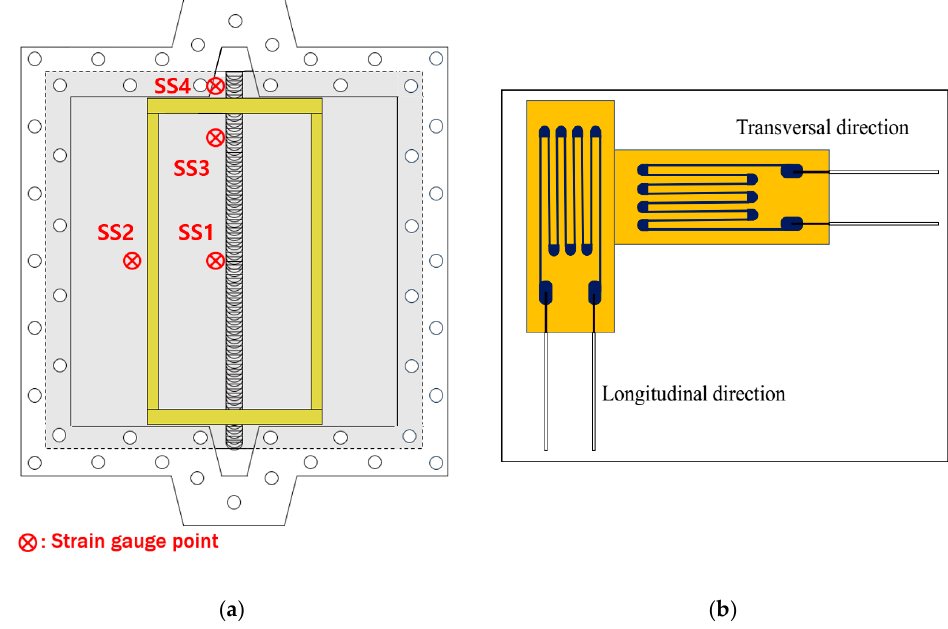
Figure 3. ( a ) Arrangement and ( b ) layout of strain gauges at each testing point.